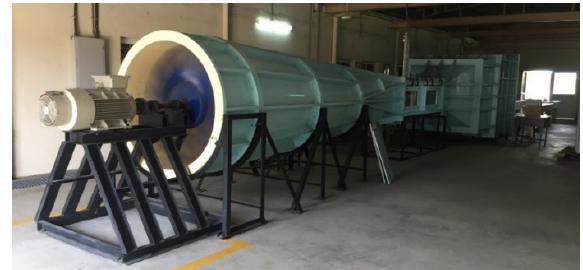
Figure 28. Wind tunnel.